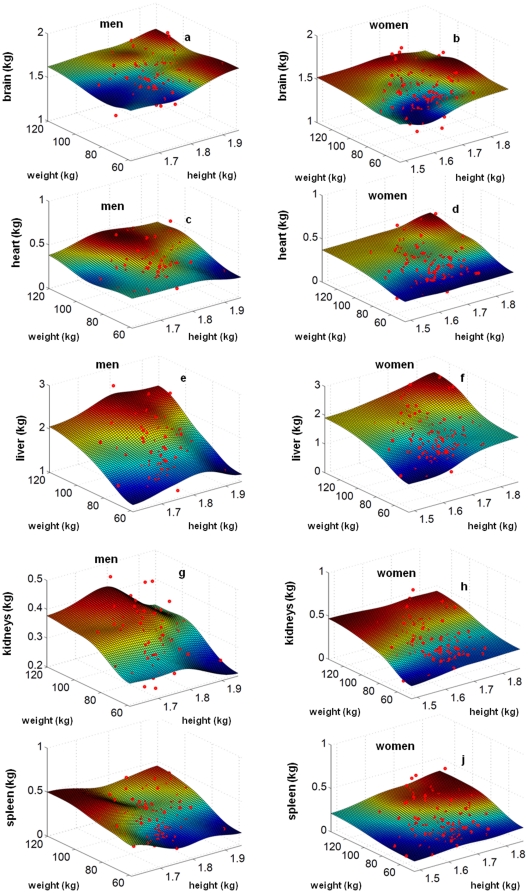
Masses of brain, heart, liver, kidneys and spleen plotted against height and weight for men (a,c,e,g,i) and women (b.d,f,h,j).